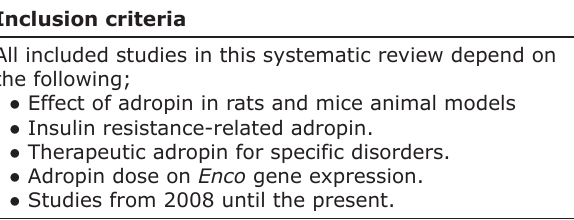
Table-1: Inclusion criteria of systematic review.